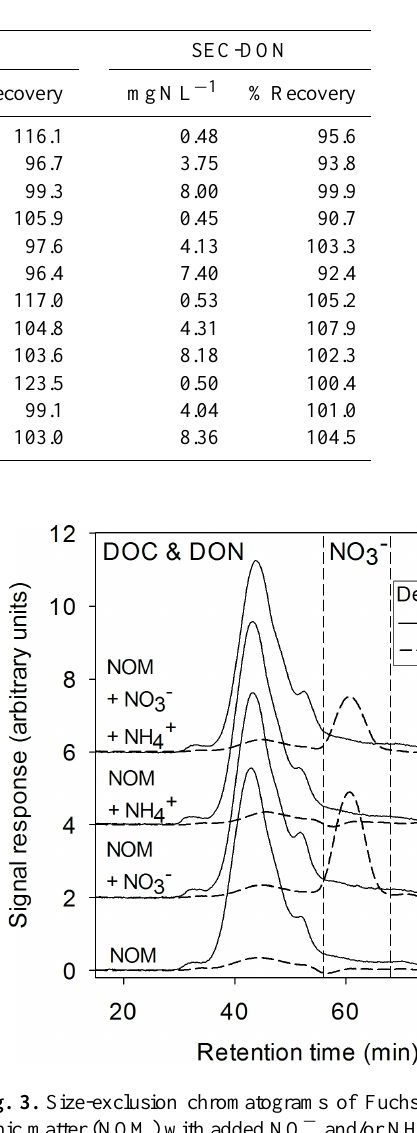
and/or NH + . Please see Ta- 3 4